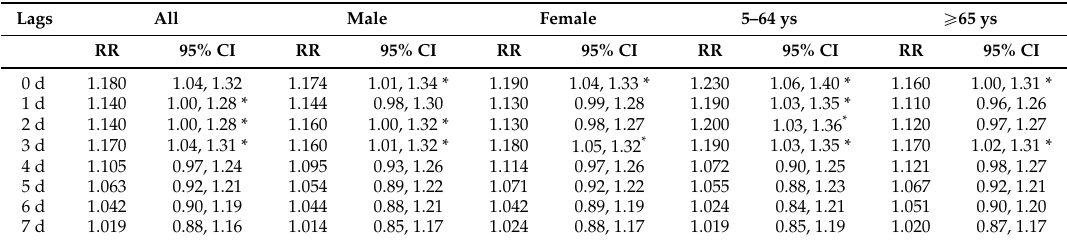
Table 3. Relative risks (RRs) of outpatient visits due to CHD in smog period from 2 to 9 December